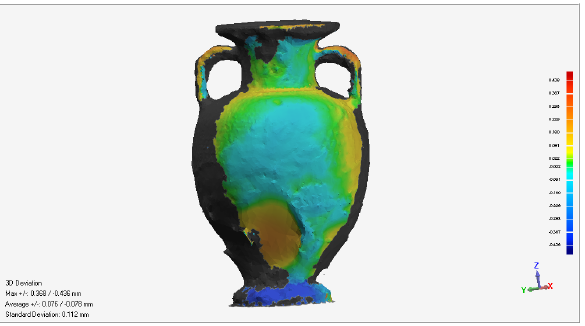
Figure 9. Accuracy evaluation for the reconstructed